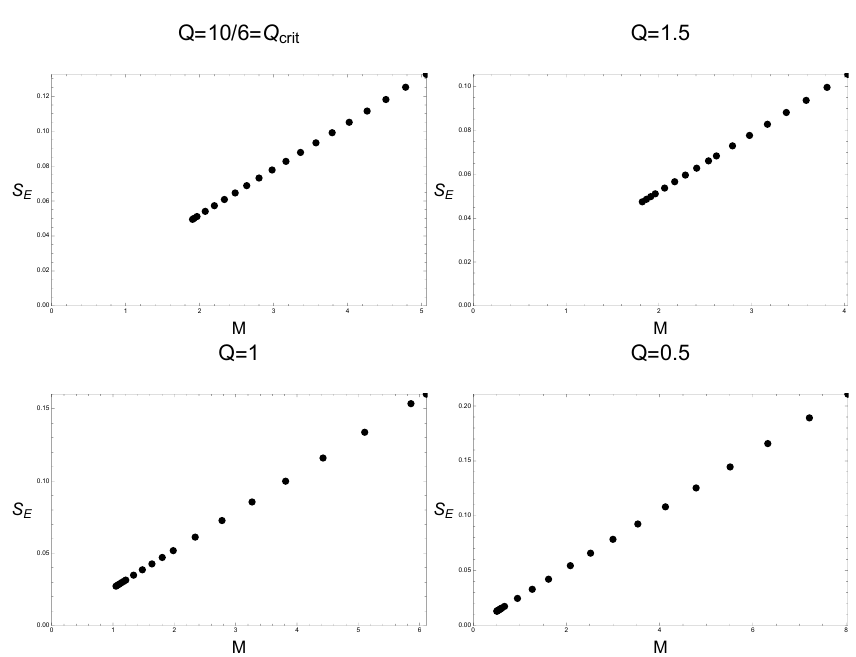
Figure 6 . The (cid:12)rst law for relative entanglement entropy. These plots show various isocharges in the black hole mass-entanglement entropy plane for the charged AdS black hole in d = 4 dimensions. The graphs verify that S E / M and thus verify the (cid:12)rst law of entanglement entropy. Q=Q Relative Error c Areas: eq. (2.14)